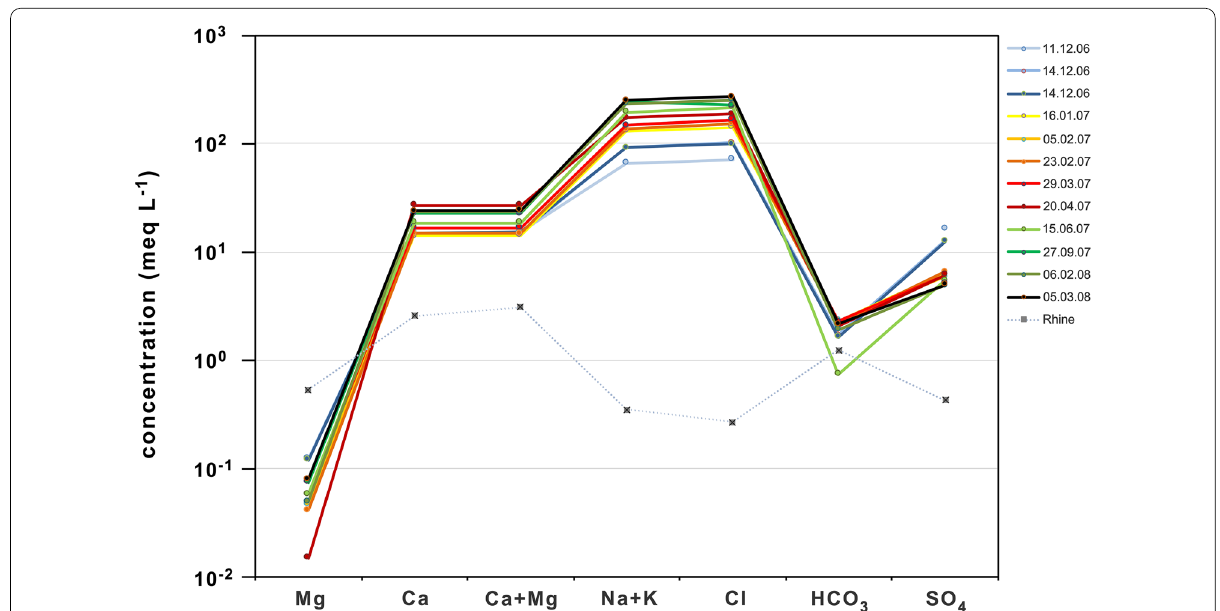
Fig. 7 Schoeller-diagram showing the main water components of water samples of the Basel-1 outflow and of the river Rhine